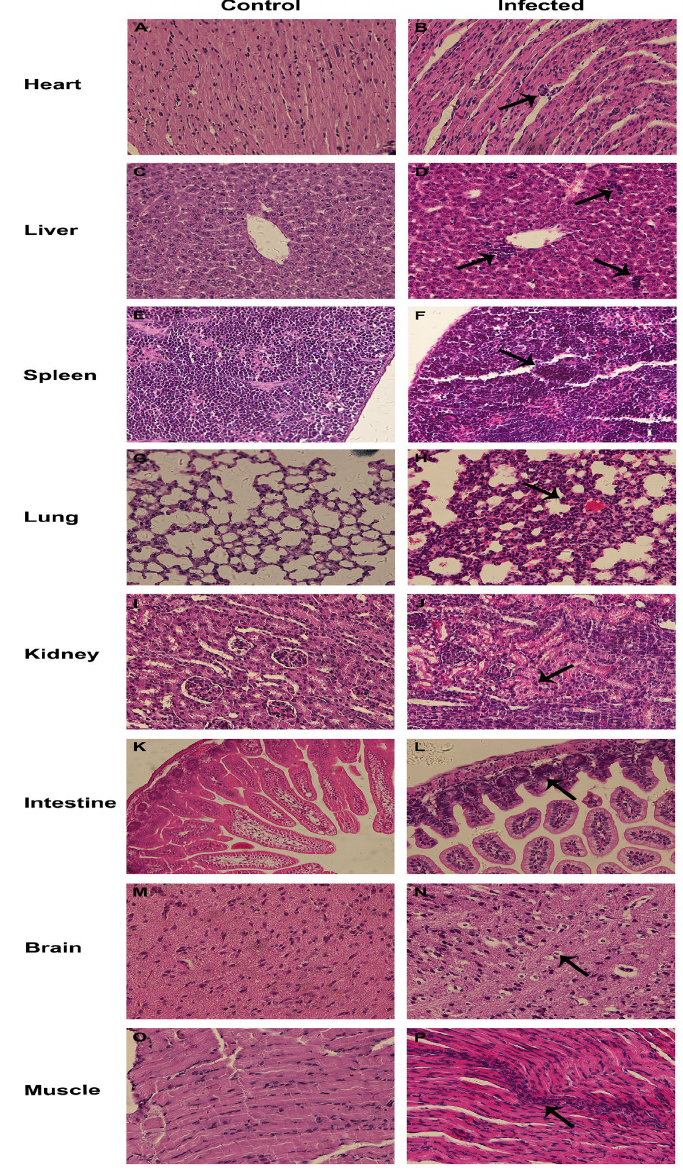
Figure 6. Histopathological lesions revealed in mice infected with CEV-JL14. Three-day-old ICR suckling mice were injected with 2 × 10 6 TCID 50 CEV-JL14 via different infective routes. The mice were euthanized 5 dpi. Tissue samples were collected and processed for histopathological examination using H&E staining. The representative results are shown. Obvious histopathological lesions and inflammatory cell infiltration were observed in the heart ( B ), liver ( D ), spleen ( F ), lung ( H ), kidney ( J ), intestine ( L ), brain ( N ), and muscle ( P ), as indicated by arrow in comparison with corresponding tissues in control mice ( A , C , E , G , I , K , M , O ). Tissues including the heart ( B ), liver ( D ), and kidney ( J ) were obtained from mice inoculated via intramuscular injection. Spleen ( F ) and muscle ( P ) were from mice inoculated via intraperitoneal injection. Lung ( H ) was harvested from mice inoculated via intranasal administration. Intestine ( L ) was collected from mice inoculated via subcutaneous injection. Brain ( N ) was from mice inoculated via oral